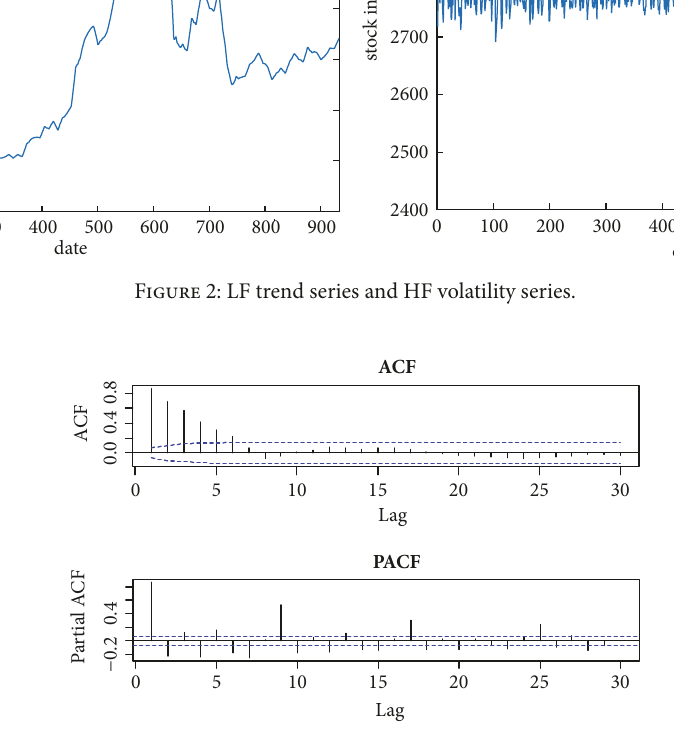
Figure 3: Autocorrelation and partial correlation function of the differential series.